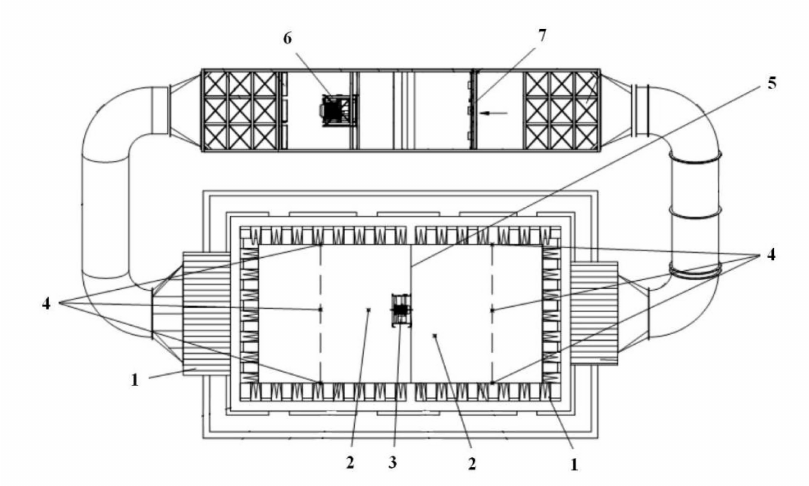
Figure 3. Semi-anechoic room. Note: 1, wedge silencer; 2, noise test point; 3, tested fan; 4, pressure measurement point; 5, reflective wall; 6, auxiliary fan; 7,